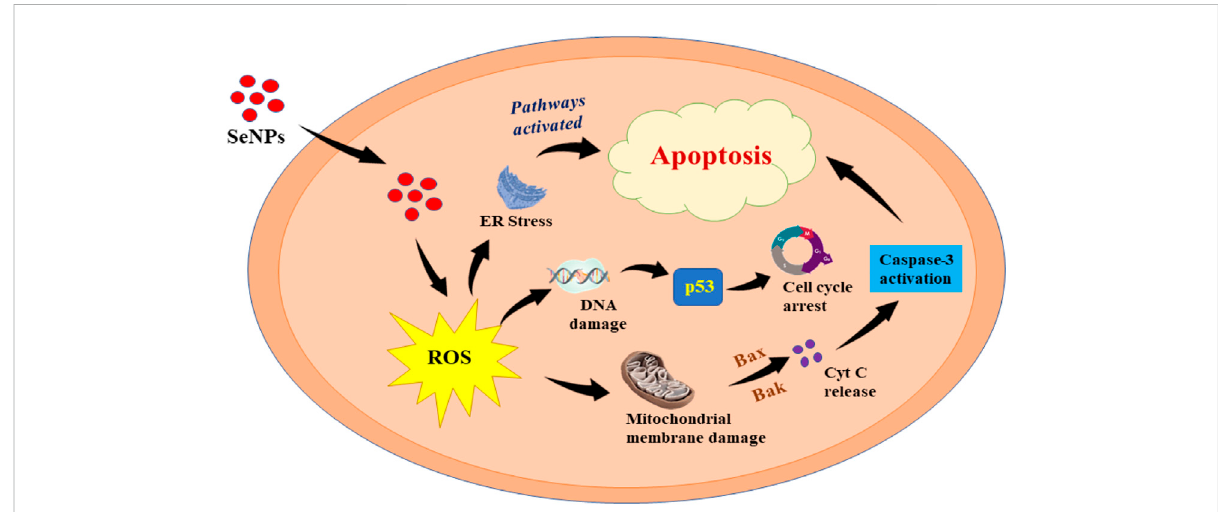
FIGURE 3 Action of SeNPs on cancer cells [modi fi ed based on Khurana et al. (2019)].